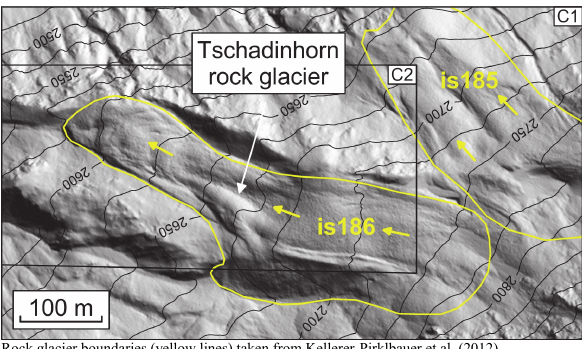
Figure 2. Shaded relief of the study area